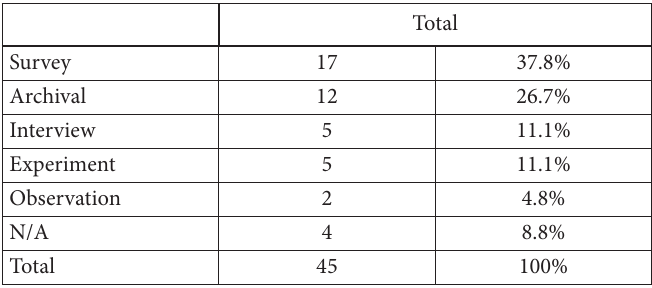
Table 9. Research methods employed (source: authors, 2019)